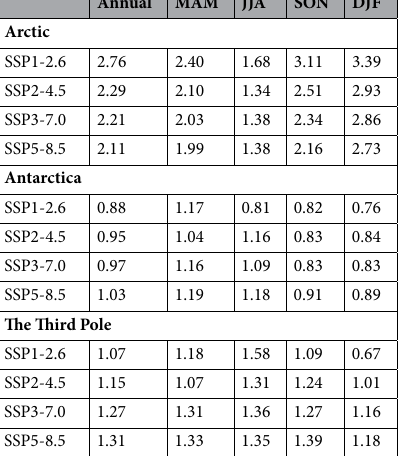
Table 1. The Amplification Index (PAI1) based on global mean over Arctic, Antarctica, the Third Pole under SSP1-2.6, SSP2-4.5, SSP3-7.0 and SSP5-8.5, respectively.